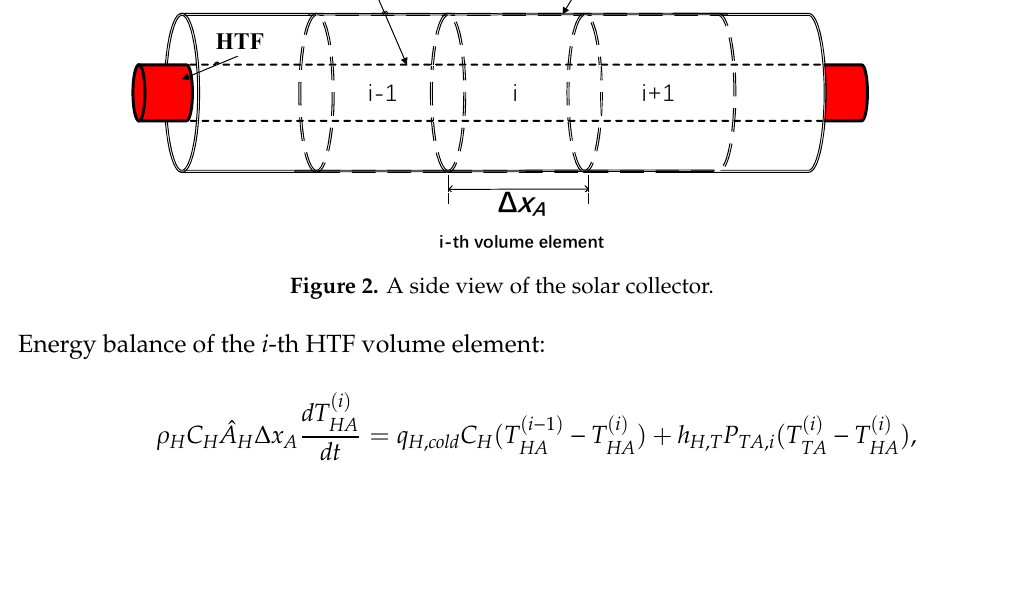
Figure 2. A side view of the solar collector.